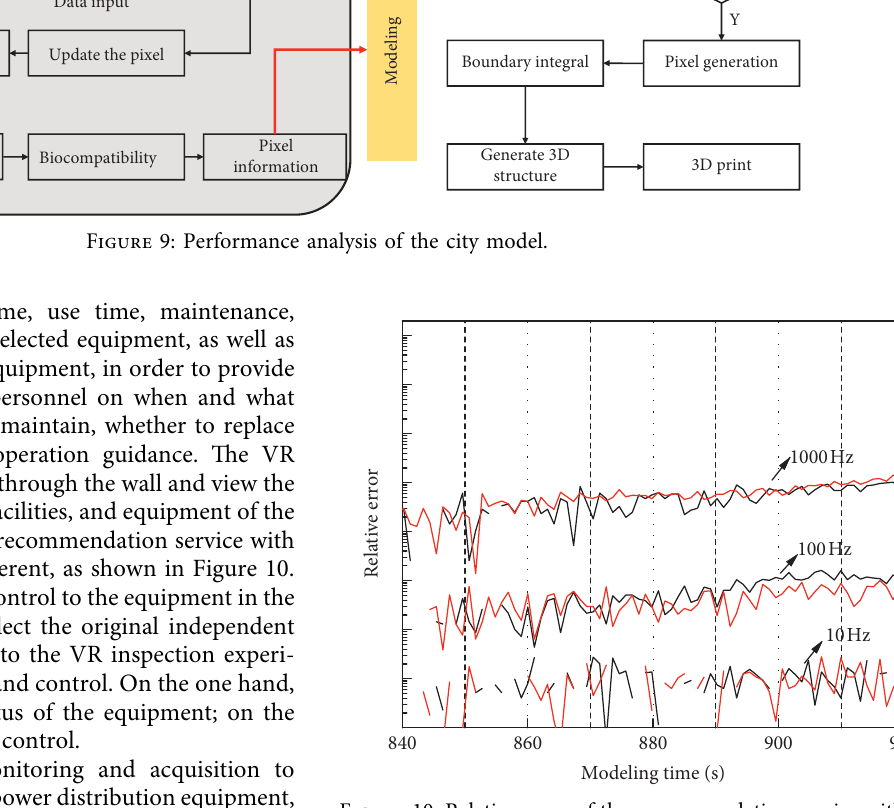
Figure 10: Relative error of the recommendation service with the modeling time.